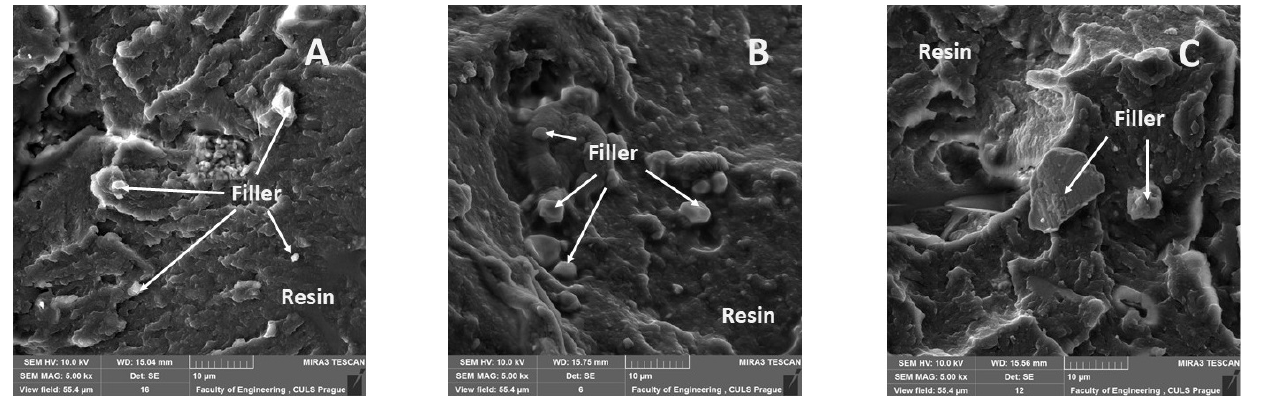
Figure 17. SEM images of fracture surface with filler CWZ-22 active carbon (MAG 5.00 k×): ( A ) mixing speed—460 rpm, ( B ) mixing speed 1700—rpm, ( C ) mixing speed—2500 rpm.